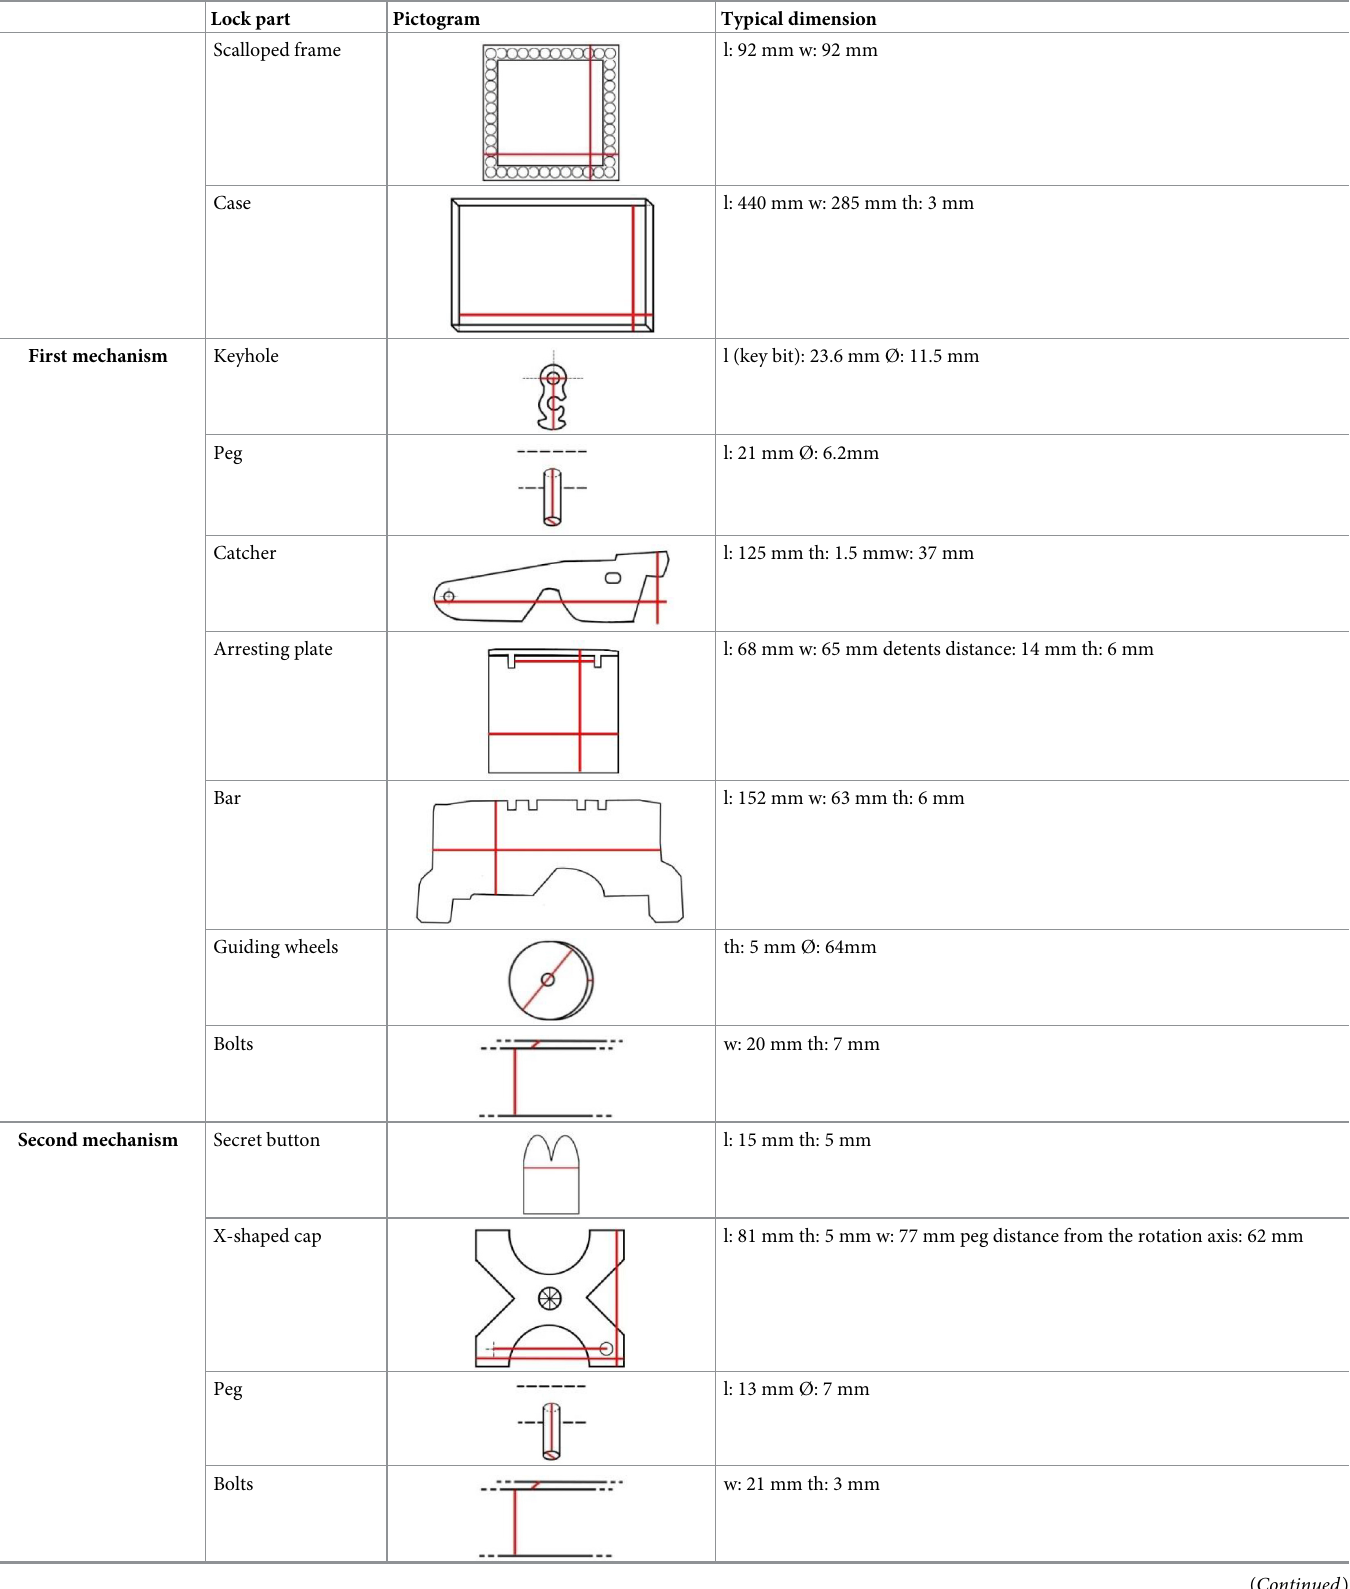
Table 1. An overview of characteristic lock parts; the typical dimensions are marked red in the pictograms (l = length, w = width, th = thickness, Ø =